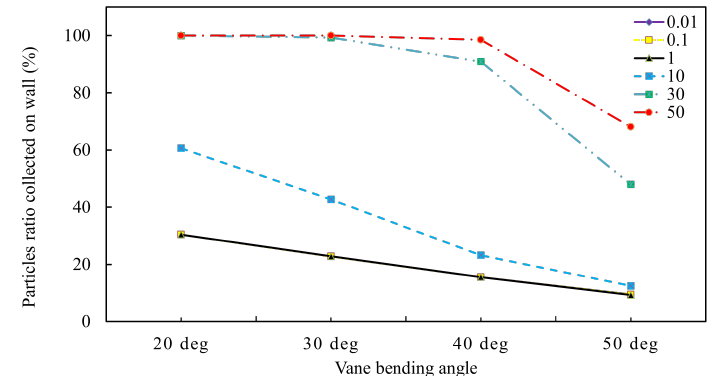
Figure 11. Effect of vane bending angles with different particle sizes.